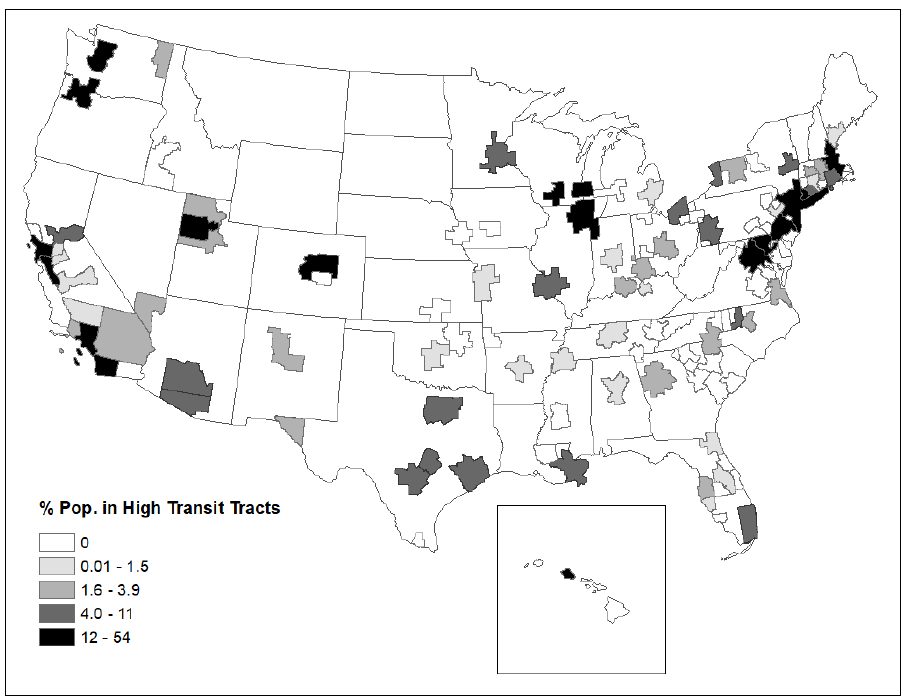
Figure 2. Percentage of urban population residing within high-transit (transit score ≥ 50 or within 1 km of a rail stop) census tracts by metropolitan area.